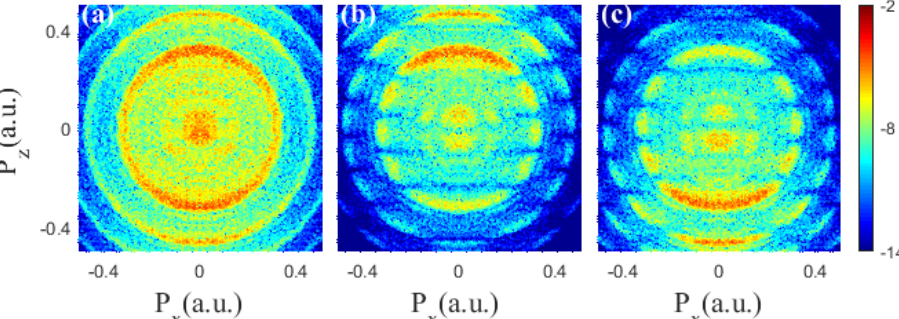
Figure 1. PMDs of Ar atom obtained by solving SFA in the parallel two − color fields with the relative phases ϕ = 0 ( a ), π /2 ( b ) and 3 π /2 ( c ),